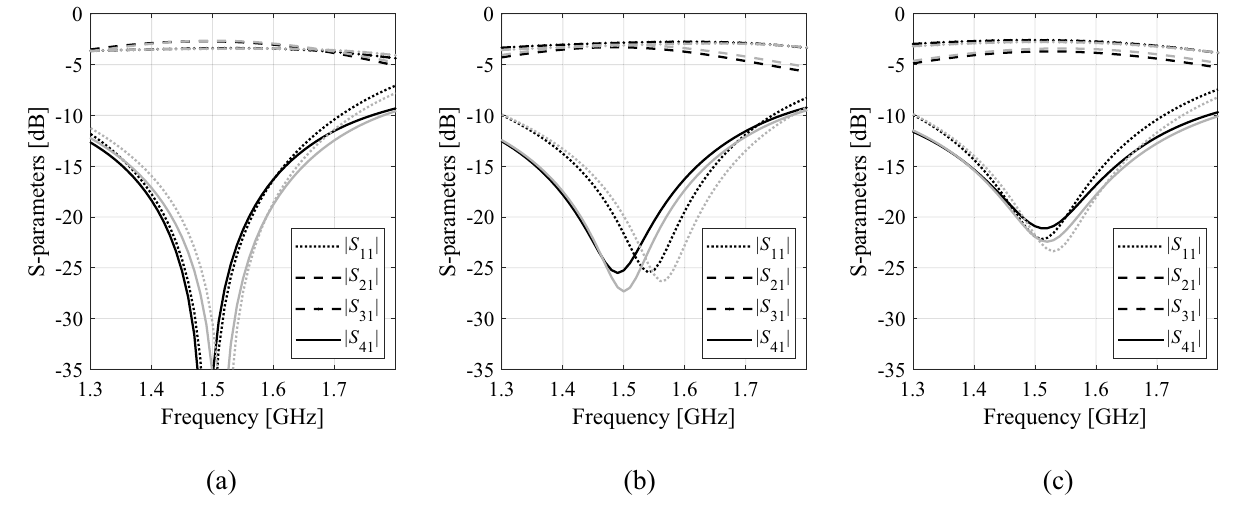
Figure 2. S -parameters for the coupler considered in Fig. 1 evaluated using the low- (gray) and high-fidelity (black) EM simulation. Observe considerable misalignment, especially in terms of the frequency shifts, yet the overall shape and the amount of misalignment is consistent for different designs shown in the pictures (plots ( a ) through ( c )).